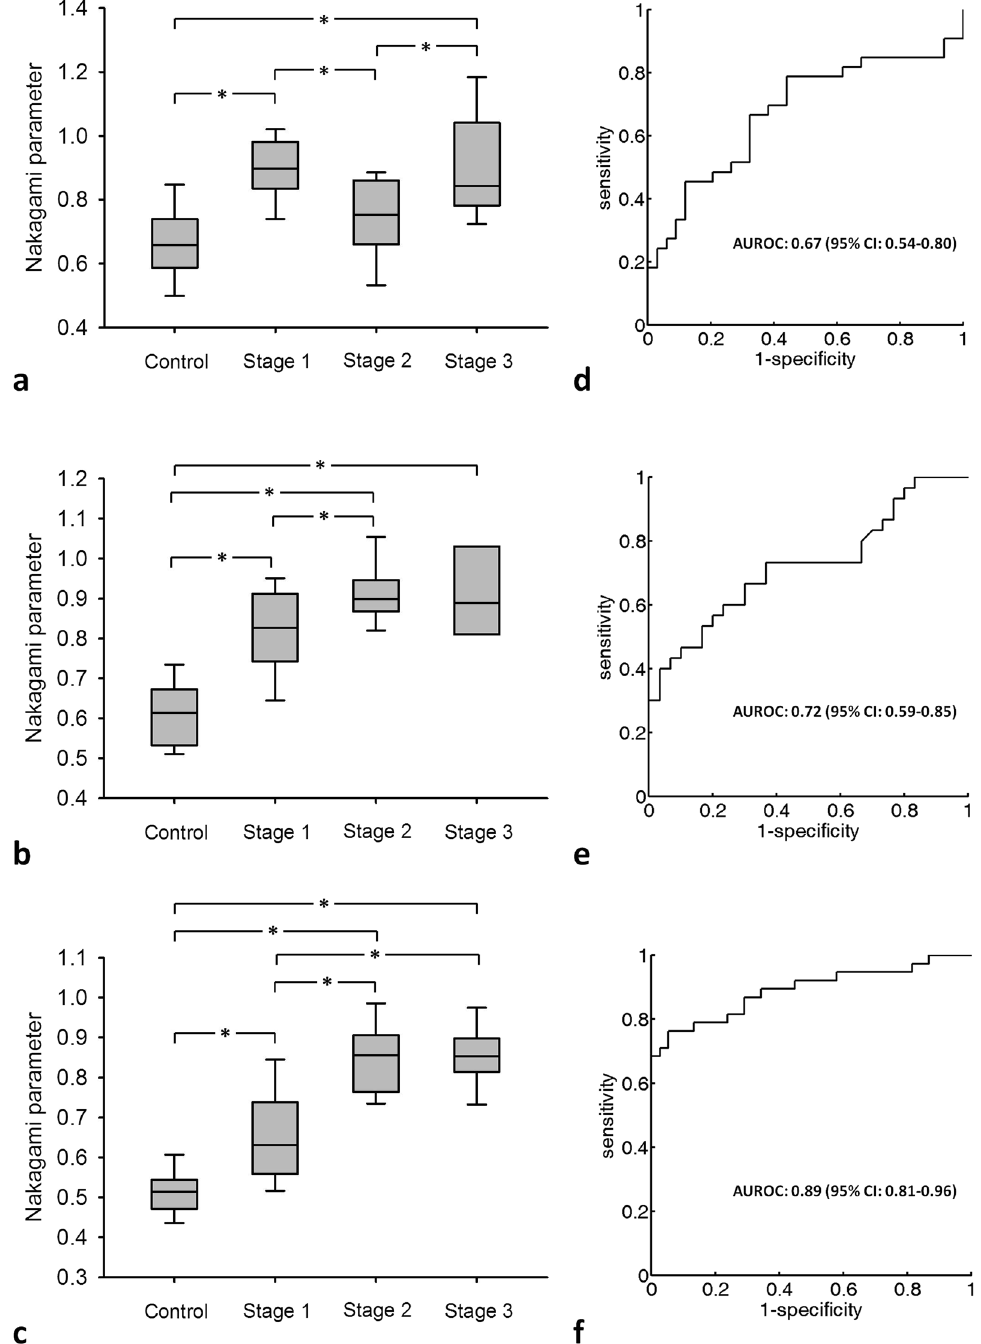
Figure 4. Nakagami parameters corresponding to different DMD stages. Data are expressed using box plots. The Nakagami parameter increases with the DMD stage, indicating that the backscattered statistics gradually change from a pre-Rayleigh distribution to a Rayleigh distribution. ( a ) Rectus femoris; ( b ) tibialis anterior; ( c ) gastrocnemius. ( d – f ) Corresponding ROC curves. The AUROC for the Nakagami parameter of the gastrocnemius muscle (0.89) is higher than those of the rectus femoris and tibialis anterior